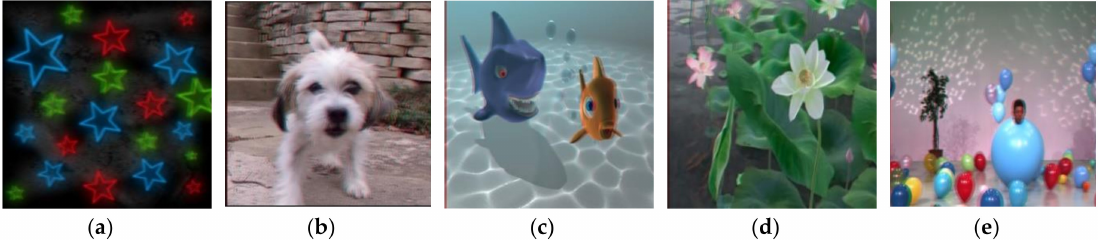
Figure 8. The tested five stereo images: ( a ) ‘stars’; ( b ) ‘dog’; ( c ) ‘fish’; ( d ) ‘lotus’; ( e )